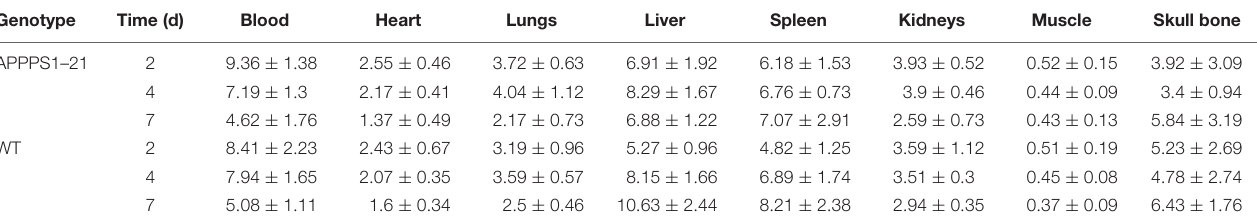
TABLE 2 | Selected ex vivo biodistribution data of [ 89 Zr]-Df- Bz-JRF/A β N/25 at different time points after intravenous injection in APPPS1–21 and WT mice. Genotype Time (d) Blood Heart Lungs Liver Spleen